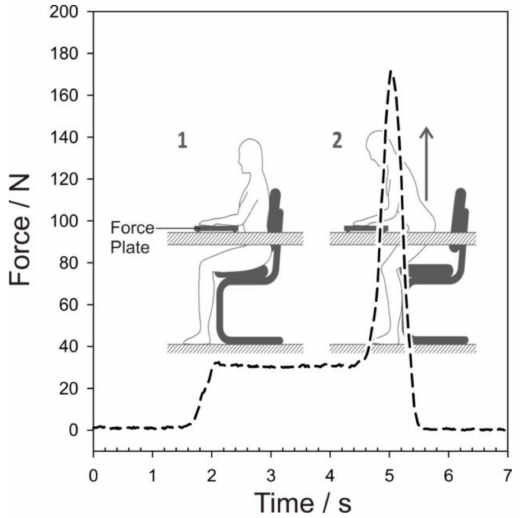
Figure 4. Variation in applied force as a consequence of resting an arm on a surface (1) and subsequently using hand-wrist leverage to raise the subject from a seated to standing position